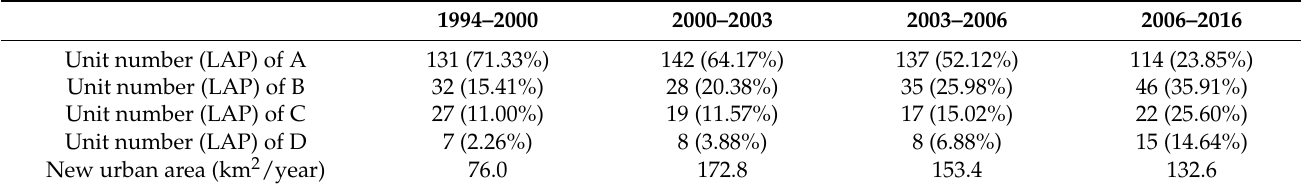
Figure 12. Urban sprawl extent within districts of Shanghai, China. Table 8. Statistical information about the extent of different sprawls.